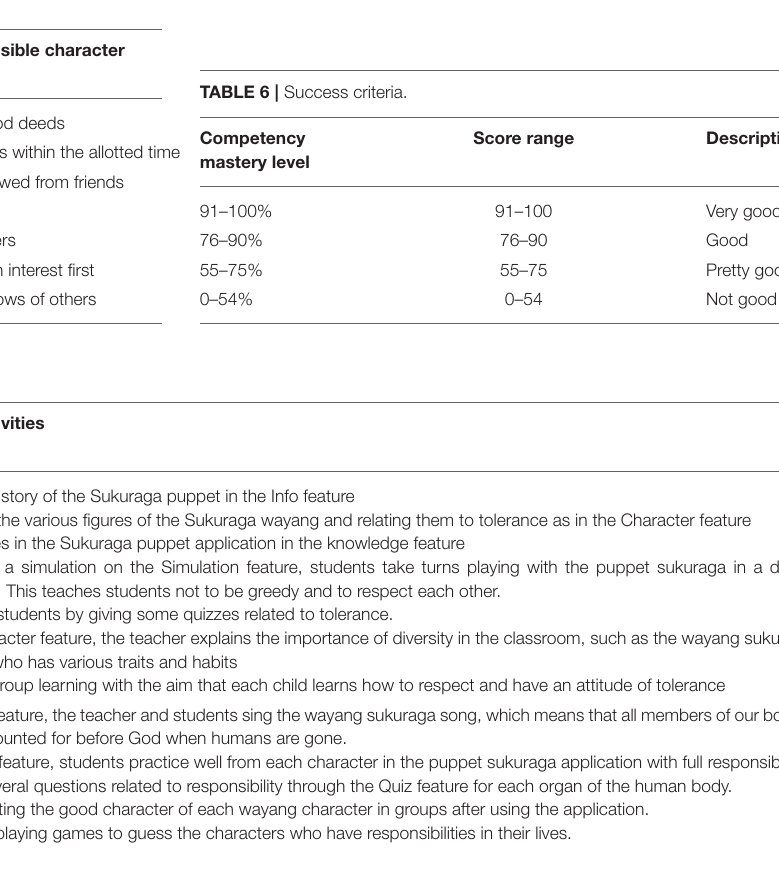
TABLE 4 | Responsibility character indicator.